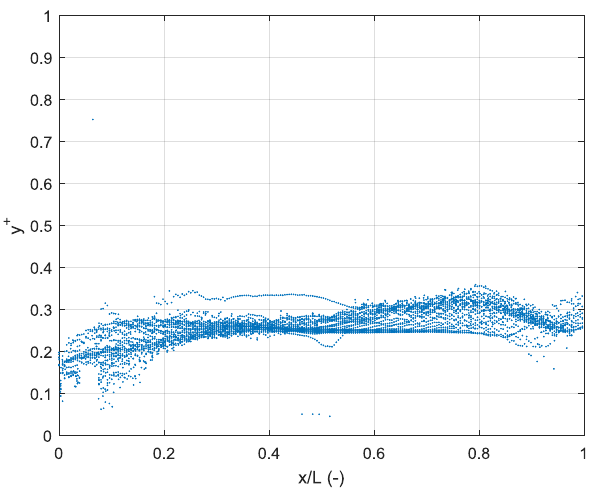
Figure 5. The y + distribution on the ship hull at F h = 0.77, sampled at 40 s physical time.